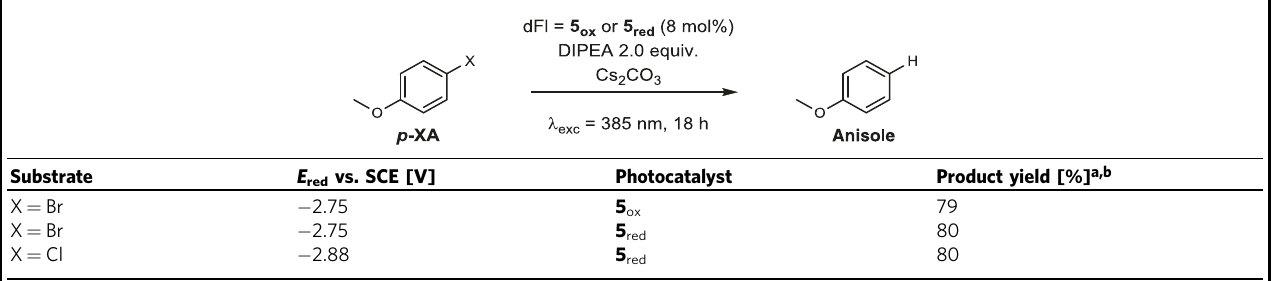
Table 2 Photocatalytic dehalogenation of p -bromoanisole by deaza fl avin in dependence on the basicity.